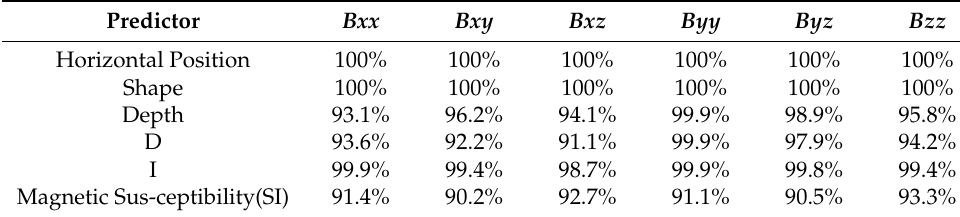
Table 2. Model prediction accuracies of Rectangle.